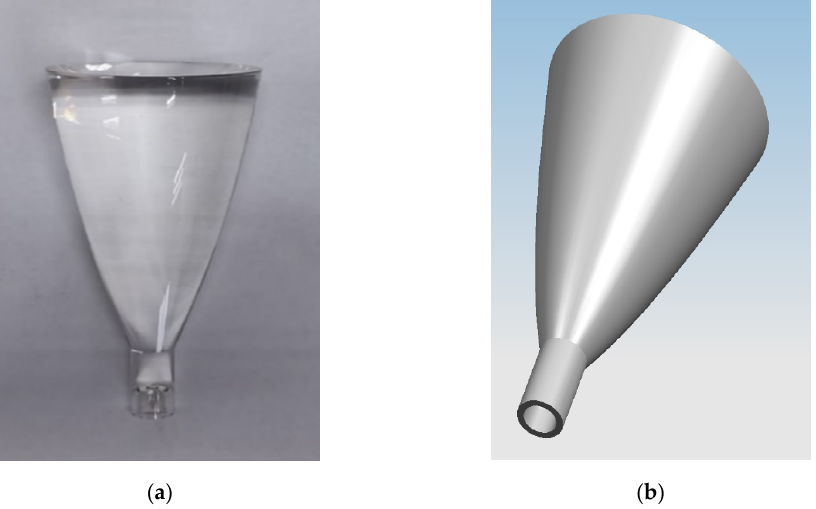
Figure 2. ( a ) Physical photo of the concave outlet concentrator. ( b ) A computer model of the concave outlet concentrator.